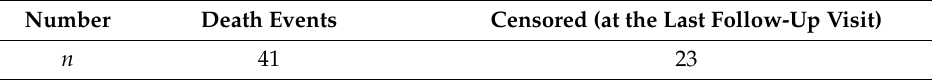
Table 4. Overall survival